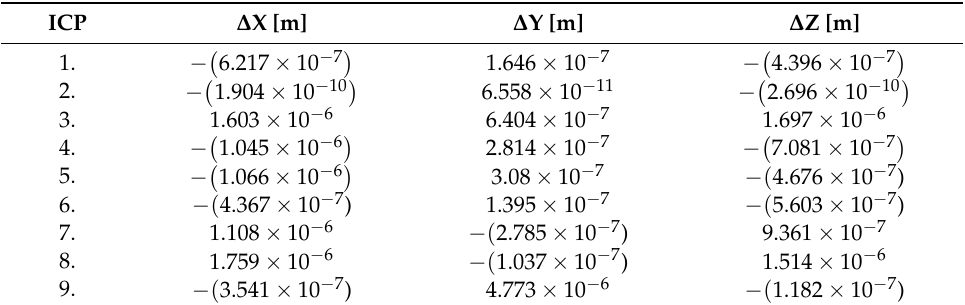
Accuracy of ICP (Independent Control Points) of MCT (MCIT) transformation in laboratory experiment.